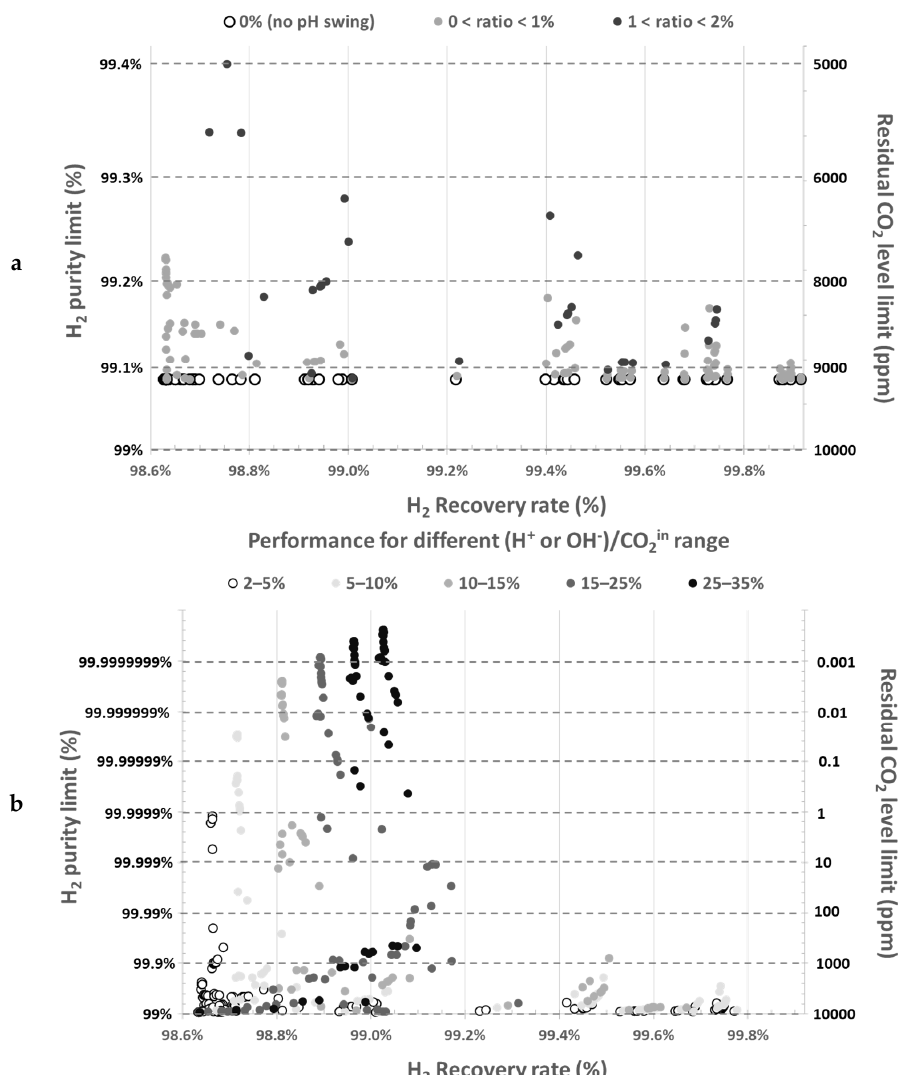
Figure 3. Residual CO 2 levels in the absorbent as a function of (H + or OH − )/CO 2 ratio. ( a ) Results obtained without pH swing or low ratios and ( b ) Results obtained for larger ratios.